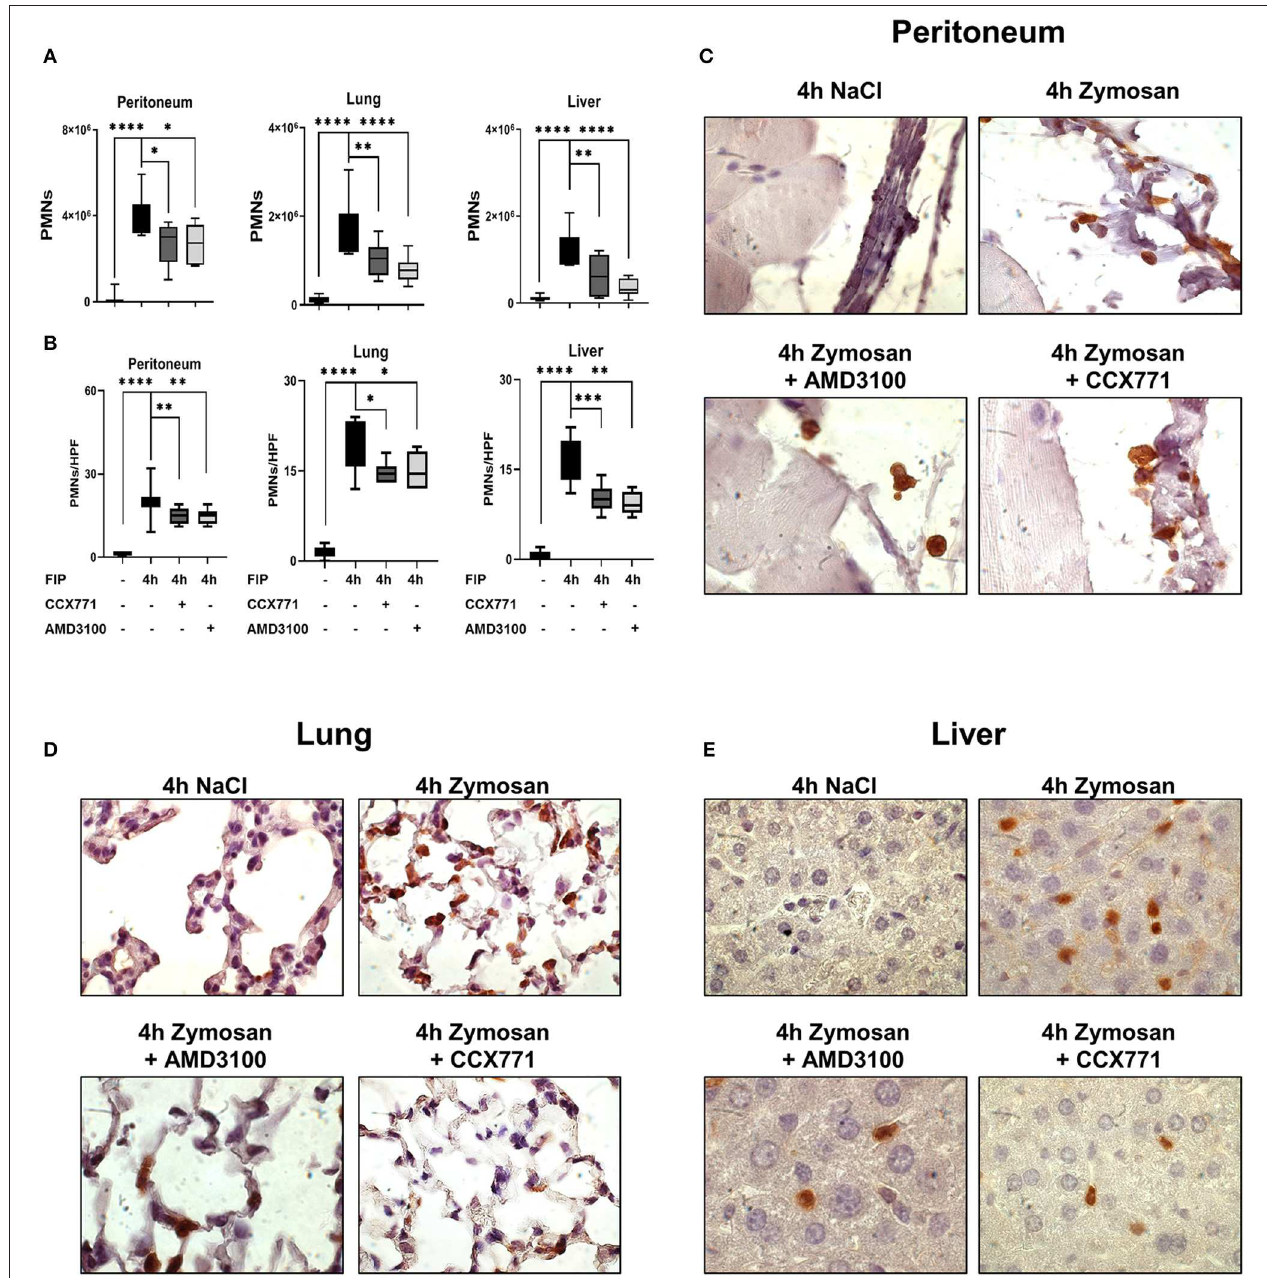
FIGURE 6 | Pharmacological modulation of CXCR7 and CXCR4 dampens PMN accumulation during polymicrobial peritonitis. (A) In wild type animals, PMN counts in peritoneal, lung and liver tissue were evaluated by flow cytometry after injection of autologous feces and the effects of AMD3100 and CCX771 determined. Immonofluorescence staining marked PMNs brown and neutrophil infiltration was assessed and counted per high power field (B) , (C) in the peritoneum, (D) lung and (E) liver tissue at indicated conditions. Images are representatives of n = 3 experiments. For statistical analysis, one-way ANOVA was used with Bonferroni post-hoc test. Data are presented as box and whisker graph with error bars indicating the range from minimum to maximum value; n = 6–12; * p < 0.05; ** p < 0.01; *** p < 0.001, and **** p < 0.0001. of CXCR7 elevated gene expression of occludin, TJP1, TJP3, claudin 1, and 5. The selective CXCR4 antagonist ameliorated gene levels of occludin, TJP1, TJP2, TJP3, e-cadherin 1, claudin 1, 3, and 5 in fecal peritonitis. Protein analyses confirmed the results from gene expression with a pivotal effect of